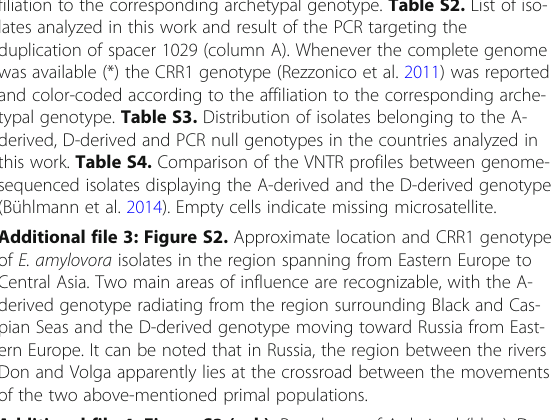
Additional file 2: Table S1. List of 82 genomes used for initial genotyping of the CRISPR repeat regions (Bühlmann 2015). The CRR1 genotype was marked in column A and color-coded according to the af- filiation to the corresponding archetypal genotype. Table S2. List of iso-